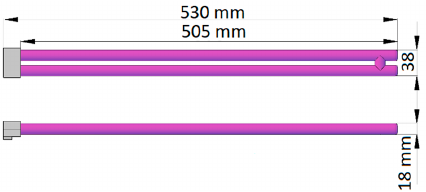
Figure 2. Shape and dimensions of the TUV PL-L 55 W / 4P HF 1CT / 25 emitter. The active surface is marked purple.